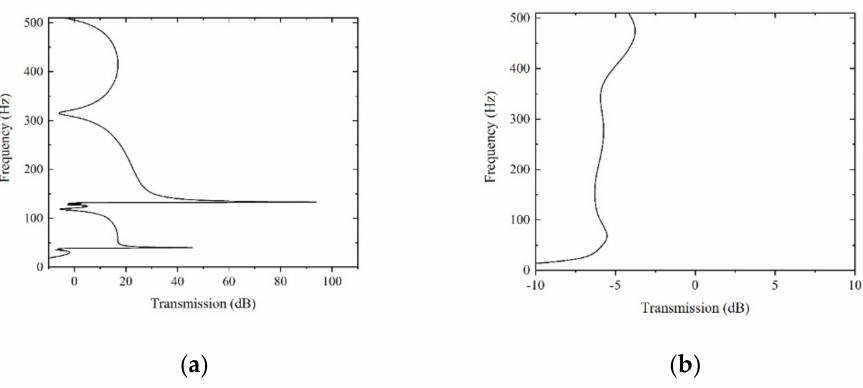
Figure 5. ( a ) Transmission spectrum of the phononic crystal; ( b ) transmission spectrum of the control group.